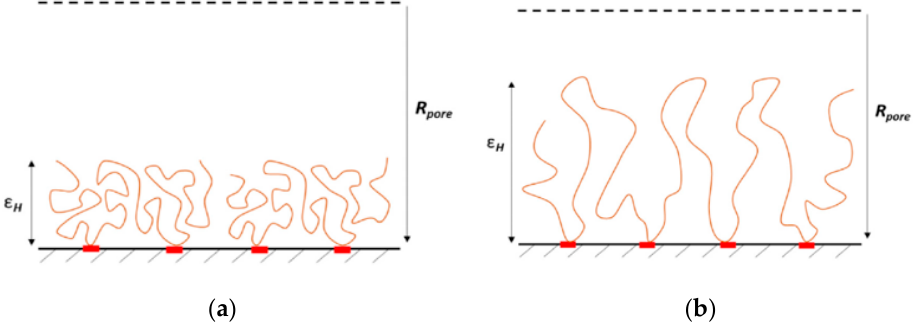
Figure 13. Polymer retention in the presence of ( a ) injection water and ( b ) smart water [180]. Substantialdecreasesinpolymerretentionhavealsobeenshowninseveralstudies[118,119,178,180–182] inthepresenceofLSW(Figure14). ThedataforFigure14aregiveninTableS5oftheSupplementaryMaterials.